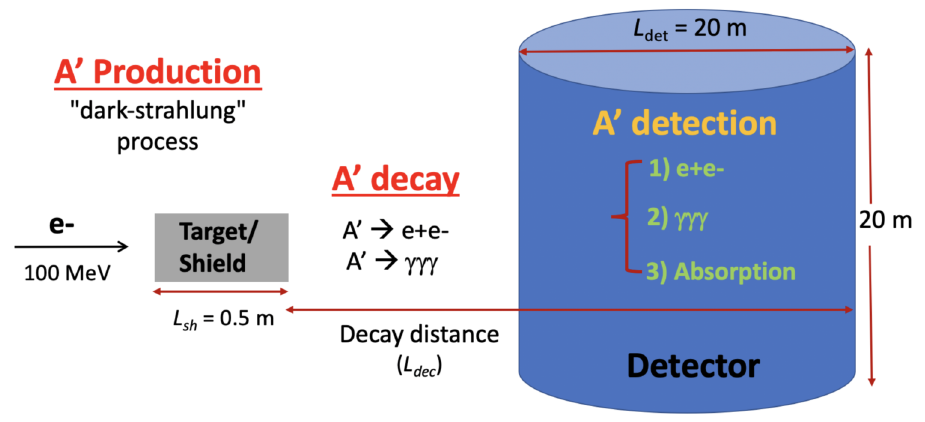
Figure 4 . A schematic diagram showing a possible experimental configuration for a dark photon search at Yemilab. The L sh ( L det ) represents horizontal length of target & shield (detector) in the direction of e − beam. Decay distance, L dec , is set as 20 m in our study but it is flexible to